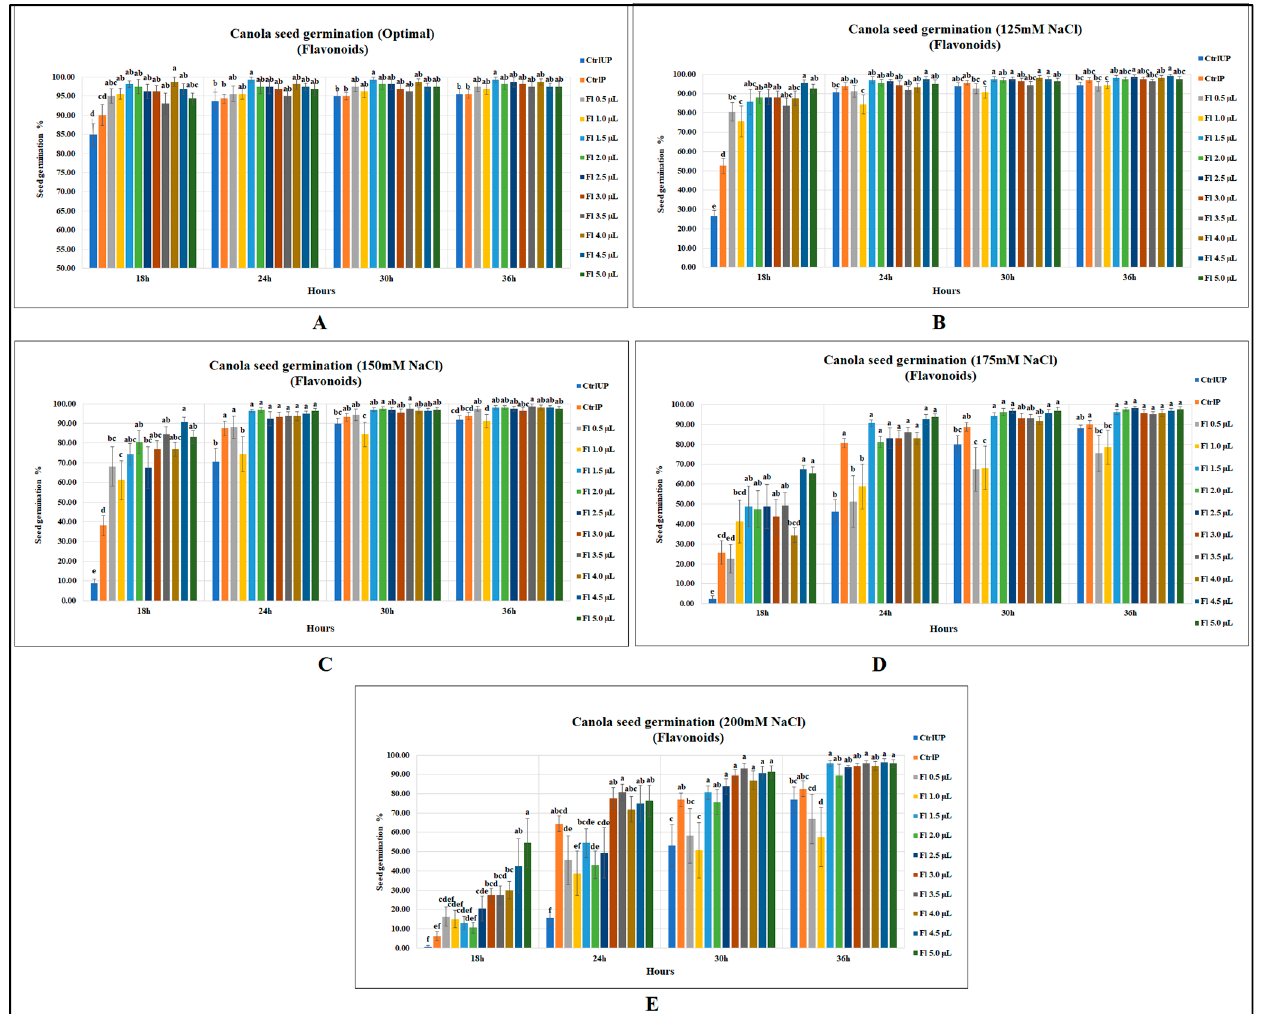
Figure 1. Flavopriming and seed germination of canola ( A ) optimal growth conditions ( B ) 125 mM NaCl ( C ) 150 mM NaCl ( D ) 175 mM NaCl ( E ) 200 mM NaCl. Data shown as mean ± SE of 8 biological replicates; different letters indicate values determined by Tukey’s multiple mean comparison to be significantly different ( p < 0.05) among treatments.